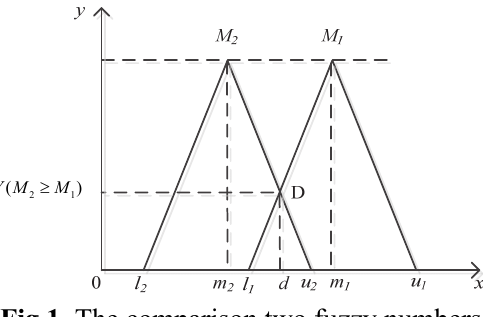
Fig.1 . The comparison two fuzzy